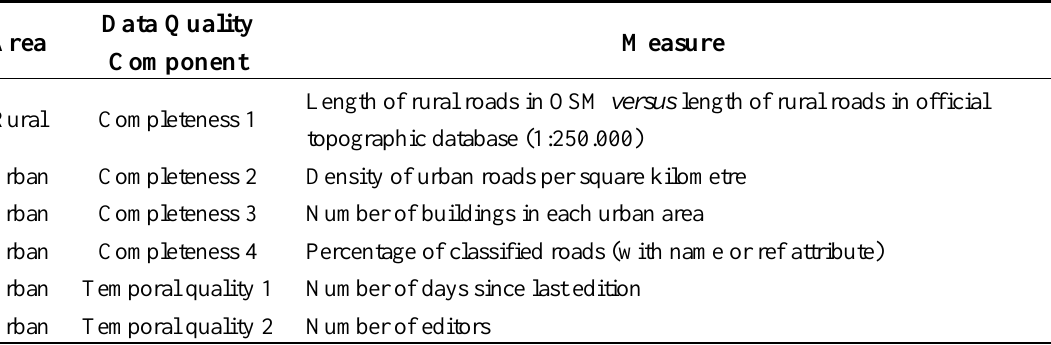
Table 2. Parameters and